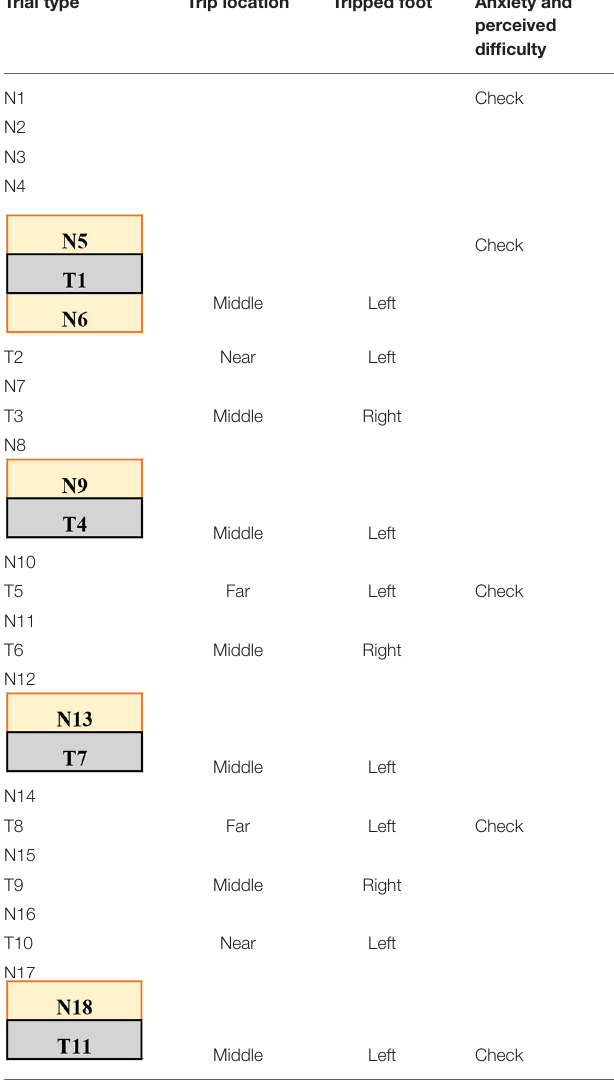
TABLE 1 | The training protocol used for both treadmill and overground training. Trial